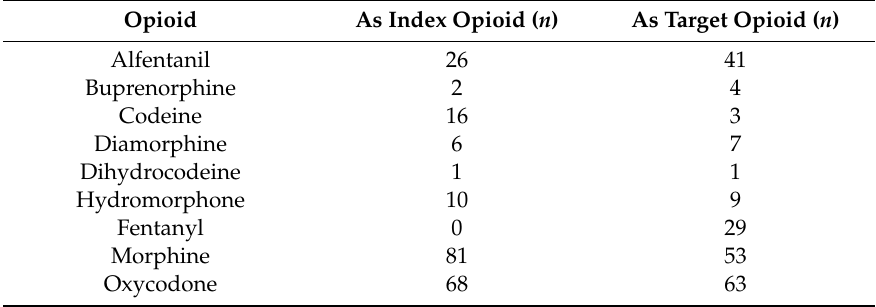
Table 1. Opioids used during the study period, recorded as the starting (index) and the resulting opioid (target) of the opioid switch. Opioid As Index Opioid ( n ) As Target Opioid ( n ) Alfentanil 26 41 Buprenorphine 2 4 Codeine 16 3 Diamorphine 6 7 Dihydrocodeine 1 1 Hydromorphone 10 9 Fentanyl 0 29 Morphine 81 53 Oxycodone 68